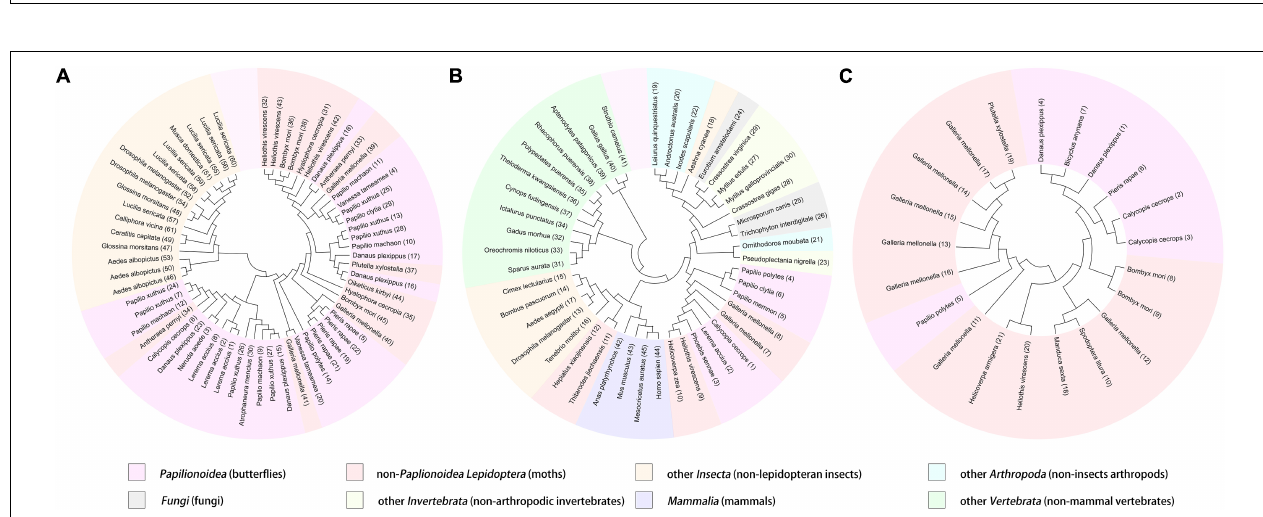
FIGURE 2 | Phylogenetic classification and visualization of butterfly AMPs. The analysis was conducted based on the amino acid sequences of cecropins (A) , defensins (B) , and moricins (C) , among butterfly AMPs and their homologous sequences.